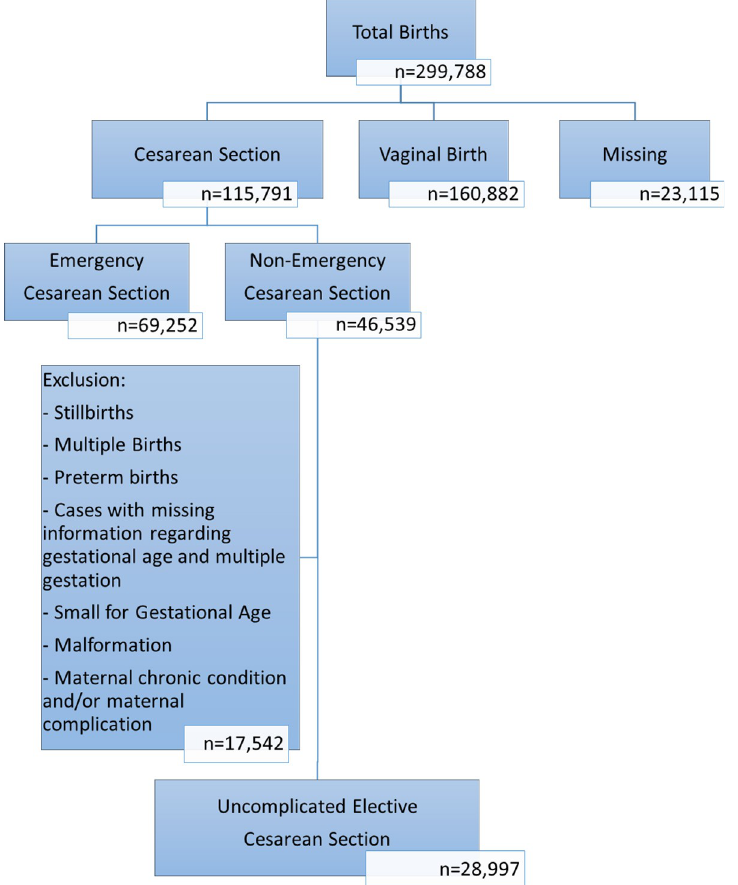
Fig 1. Flow chart detailing criteria applied to reach study